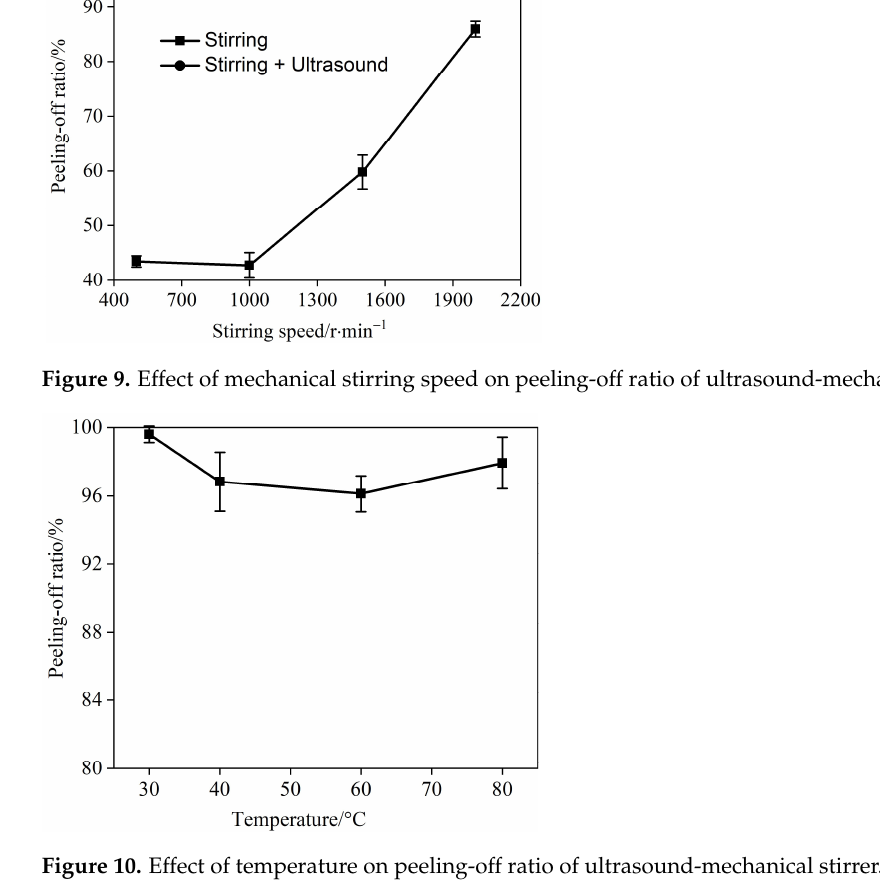
Figure 9. Effect of mechanical stirring speed on peeling-off ratio of ultrasound-mechanical stirrer.